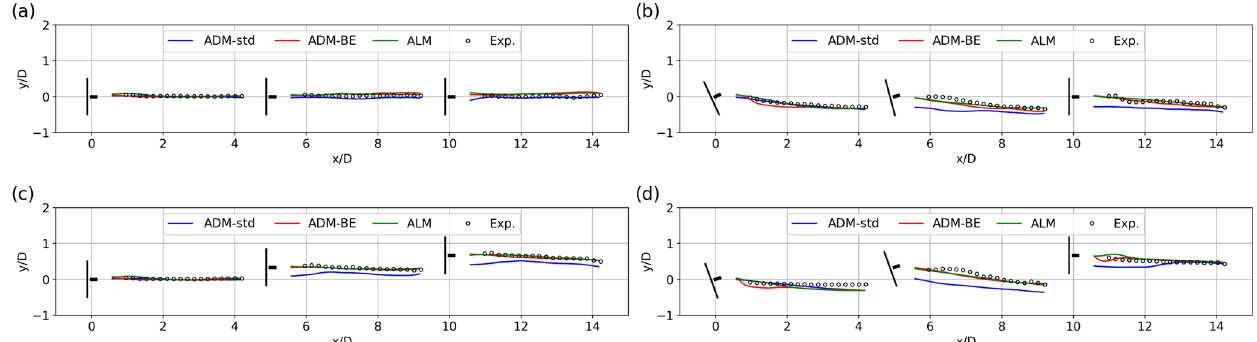
Figure 8. Trajectories of maximum velocity deficit location obtained from the wind-tunnel experiments and LES using the ADM-std, ADM- BE and ALM. (a) Case 1: γ = (0 , 0 , 0 ◦ ), zero offset; (b) Case 2: γ = (25 , 15 , 0 ◦ ), zero offset; (c) Case 3: γ = (0 , 0 , 0 ◦ ), D/ 3 offset; (d) Case 4: γ = (20 , 20 , 0 ◦ ), D/ 3